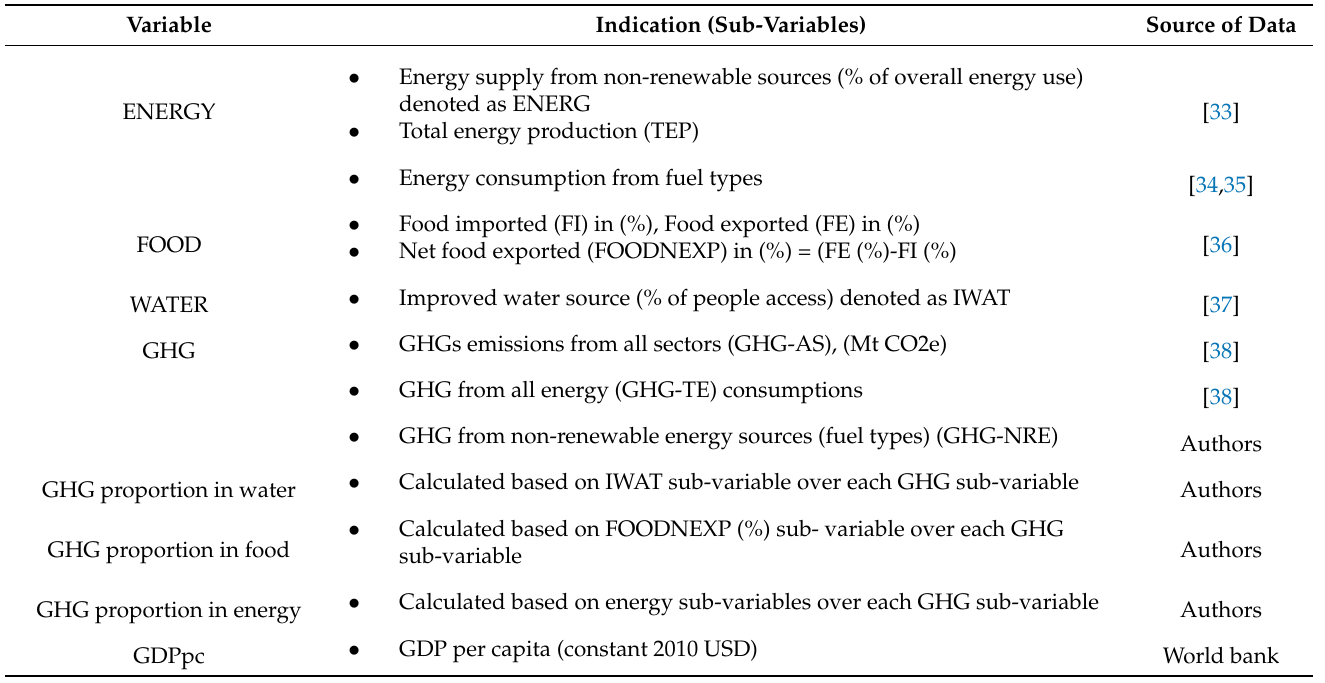
Table 1. Graphical table of data variable